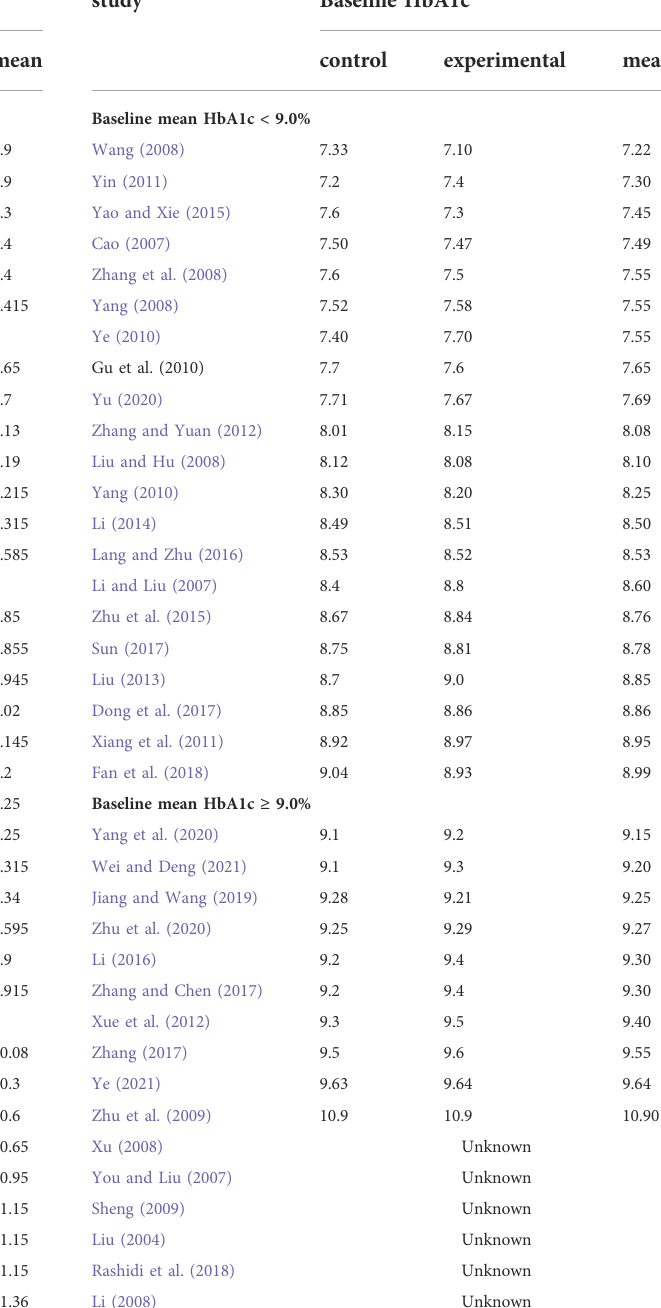
TABLE 3 Baseline mean FPG of included studies in the meta-analysis.